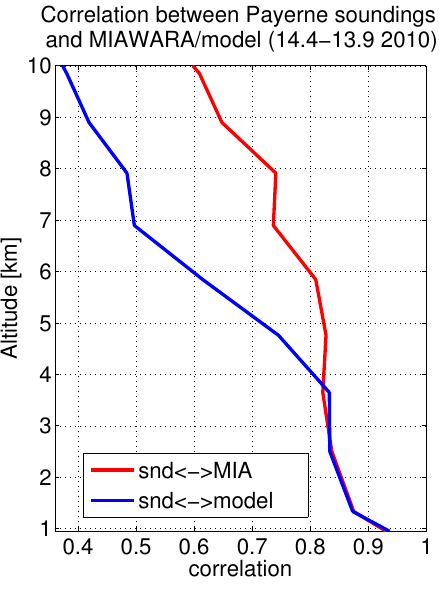
Fig. 10. Correlation between H 2 O vmr retrieved from MIAWARA and modelled from surface value (Zimmerwald meteo station) and MIAWARA-opacity against Payerne radiosoundings.